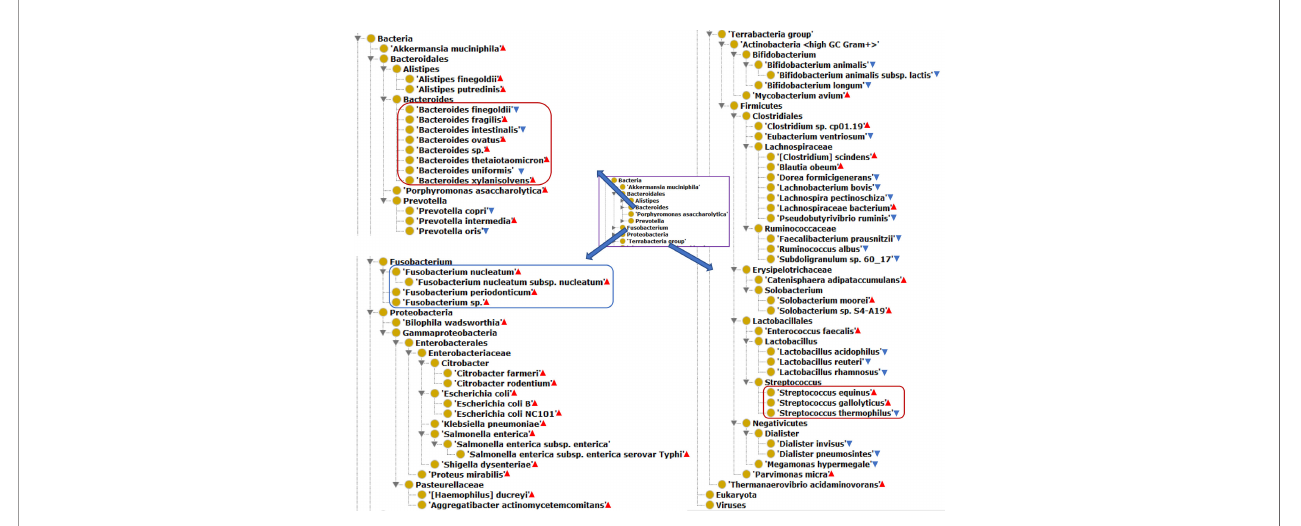
FIGURE 2 | The hierarchical structure of 63 signi fi cantly changed bacteria from the guts of CRC patients. The bacterial species presence in the gut of CRC patients. Color meanings: Red triangle - enriched species; Blue triangle - depleted